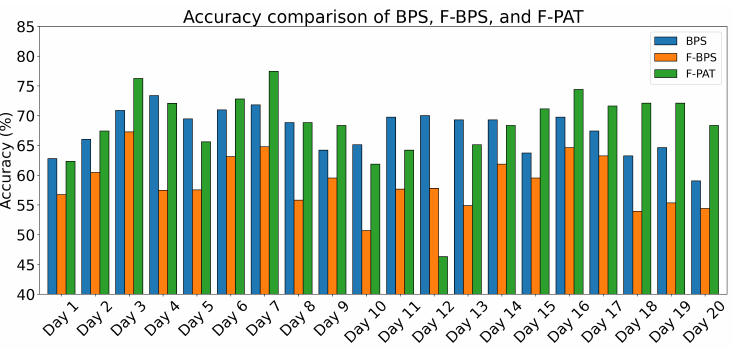
Figure 2. Abnormalities in accuracy due to VBR